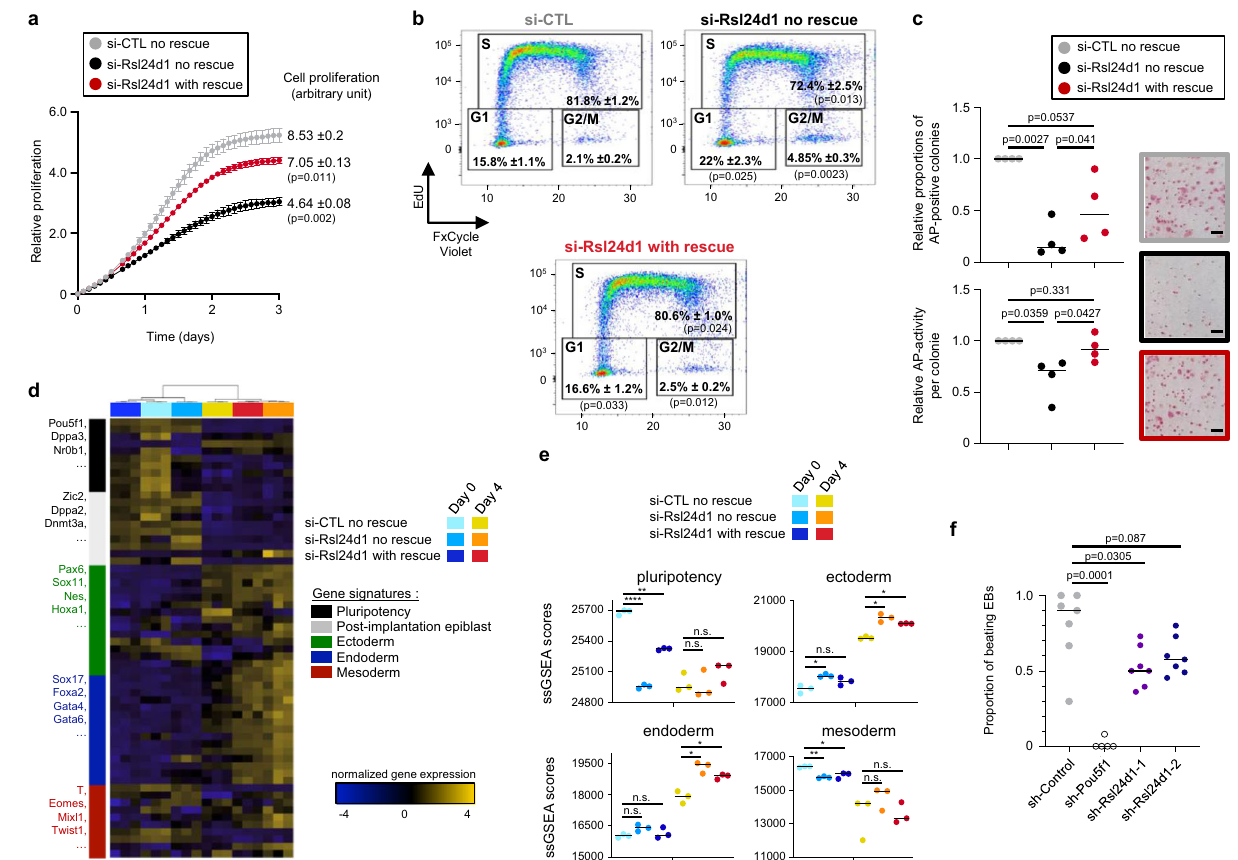
Fig. 6 | RSL24D1 is required for mouse ESC proliferation and self-renewal. a Analysis of proliferative capacities de fi ned by the cell con fl uence (Incucyte® technology) of CGR8 ESC FBS treated with si-CTL or si-Rsl24d1, without or with doxycycline-inducedRSL24D1rescue( n =3).Dataarepresentedasmeanvalues+/ − SEM.Multiplepaired t test. b FACSanalysisofEdUincorporationand DNAcontent (FXCycleViolet)inESC FBS treatedwithsi-CTLorsi-Rsl24d1,withorwithoutRSL24D1 protein rescue. The percentage of cells in the different phases of cell cycle are indicated. Two tailed Student ’ s t test. c Analysis of the self-renewing capacities of CGR8 ESC FBS estimated by the quanti fi cation of the number of individual colonies with alkaline phosphatase activity detected by colorimetric labeling (upper graph) and the relative alkaline phosphatase activity in each colony (lower graph) ( n =4). RepresentativeimagesoftheESCcoloniesareshownforthesi-CTL(grayframe),si-